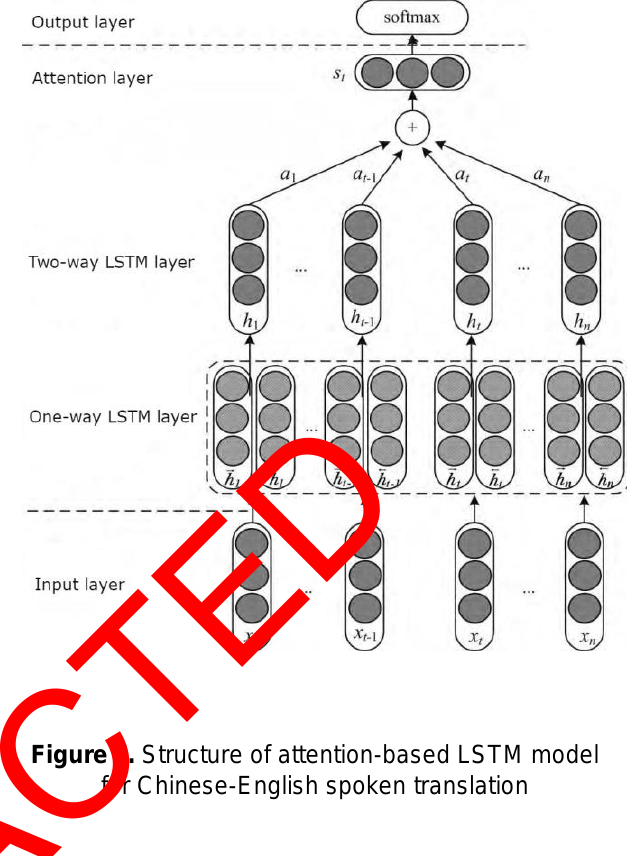
Figure 6. Structure of attention-based LSTM model for Chinese-English spoken